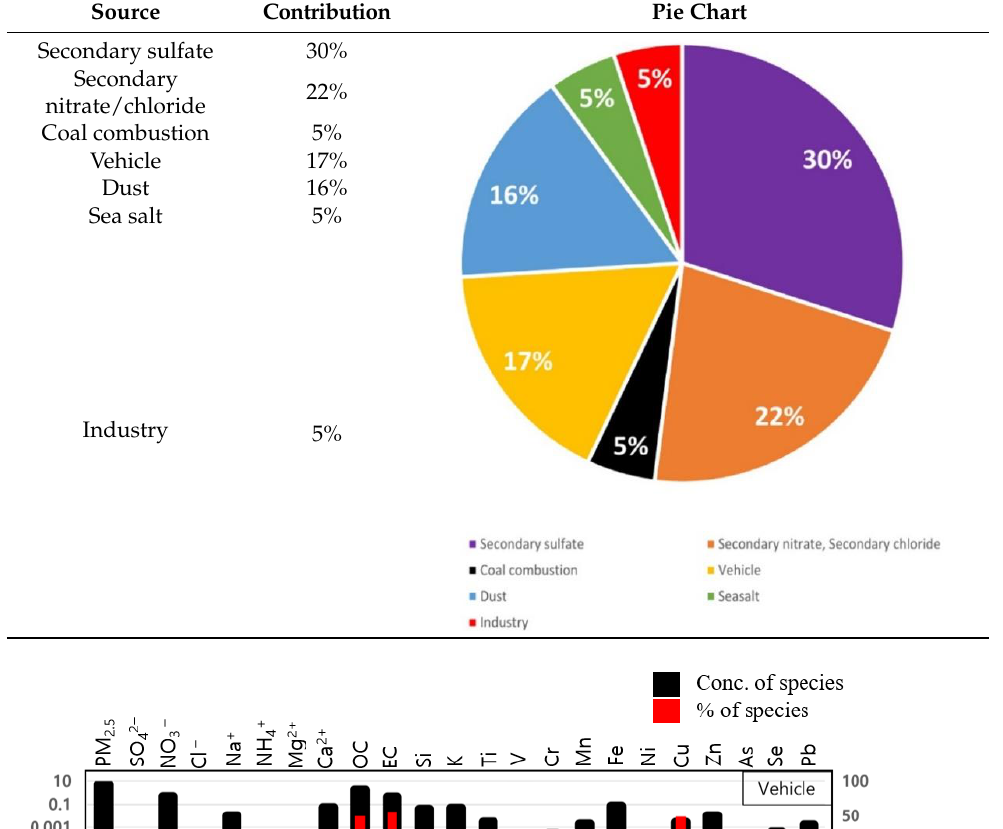
Table 2. Source contribution for seven sources during the whole measurement periods.